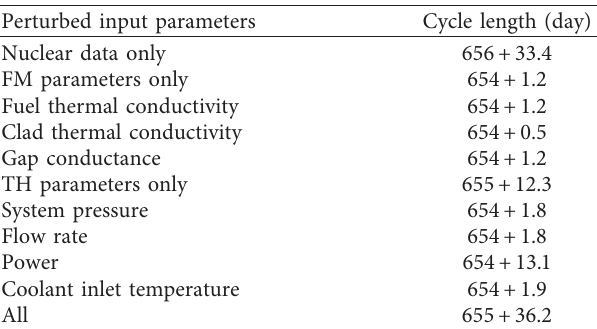
Table 4: Impact of input uncertainties on cycle length, presented as mean+(95%